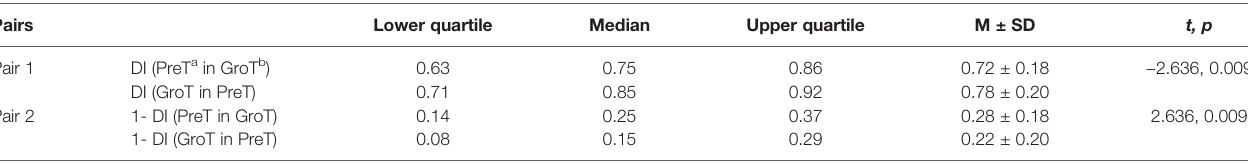
TABLE 1 | DI between the predicted and ground truth esophageal